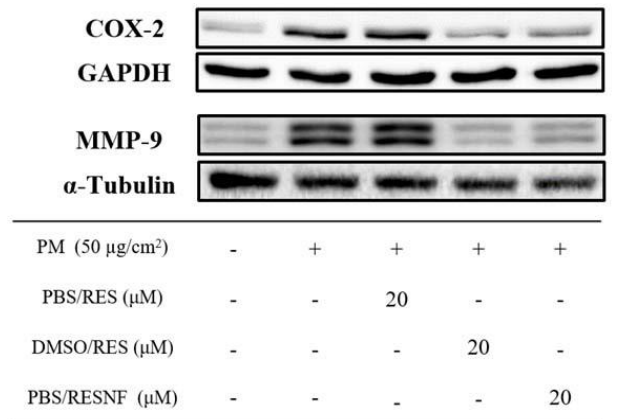
Figure9. Westernblotsdemonstratingthee ff ectsofpureresveratrolinPBS(PBS / RES),pureresveratrolin Figure 9. Western blots demonstrating the effects of pure resveratrol in PBS (PBS/RES), pure DMSO (DMSO / RES) and resveratrol nanofibers in PBS (PBS / RESNF) on particulate matter (PM)-induced resveratrol in DMSO (DMSO/RES) and resveratrol nanofibers in PBS (PBS/RESNF) on particulate protein expression of COX-2 (24 h) and MMP-9 (24 h) in HaCaT keratinocytes. Blots are representative matter (PM)-induced protein expression of COX-2 (24 h) and MMP-9 (24 h) in HaCaT keratinocytes. of three independent Blots are representative of three independent experiments.